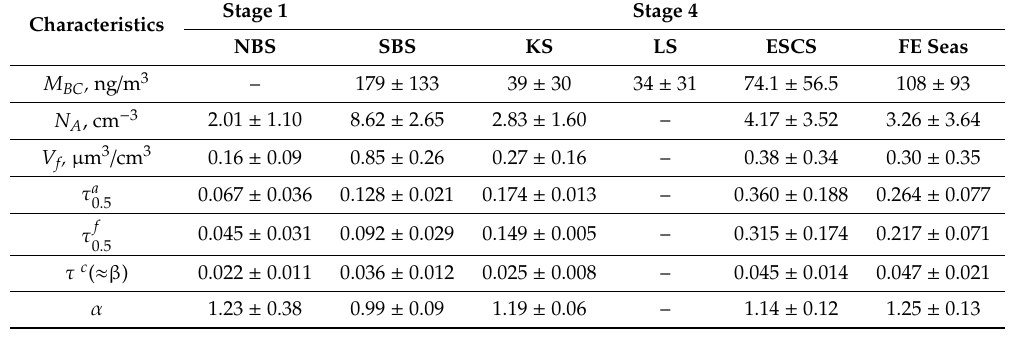
Table 4. Average ( ± SD) characteristics of aerosol in the expeditions “TransArctic–2019”. Table 4. Average (±SD) characteristics of aerosol in the expeditions “TransArctic–2019”. Characteristics